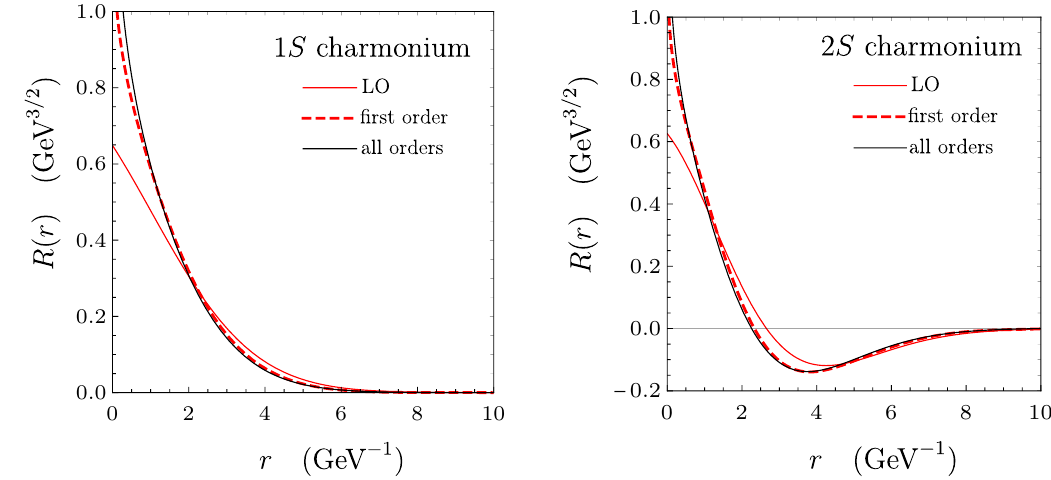
Figure 4 . Radial wavefunctions for 1 S and 2 S states including the effect of the 1 /m potential to first order in Rayleigh-Schrödinger perturbation theory (red dashed lines) compared to the all- orders calculation (black solid lines). The LO radial wavefunctions are shown as red solid lines for